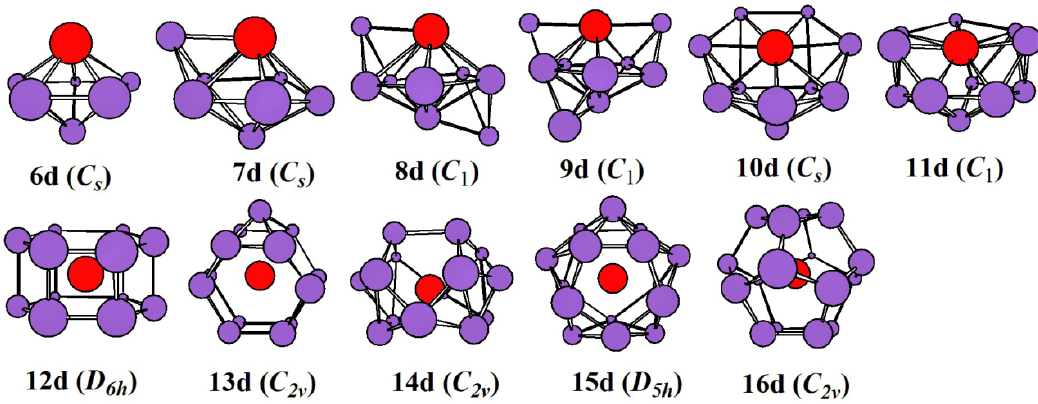
Figure 3. The lowest-energy structures of di-anionic ZrSi n 2- ( n = 6–16) and their point group. Table 1. Electronic state, average bonding energy E b (eV), and the charge on the Zr atom Q(Zr) (a.u.) of the ground state structure of ZrSi n 0 / - / 2- ( n = 6–16) clusters. ZrSi